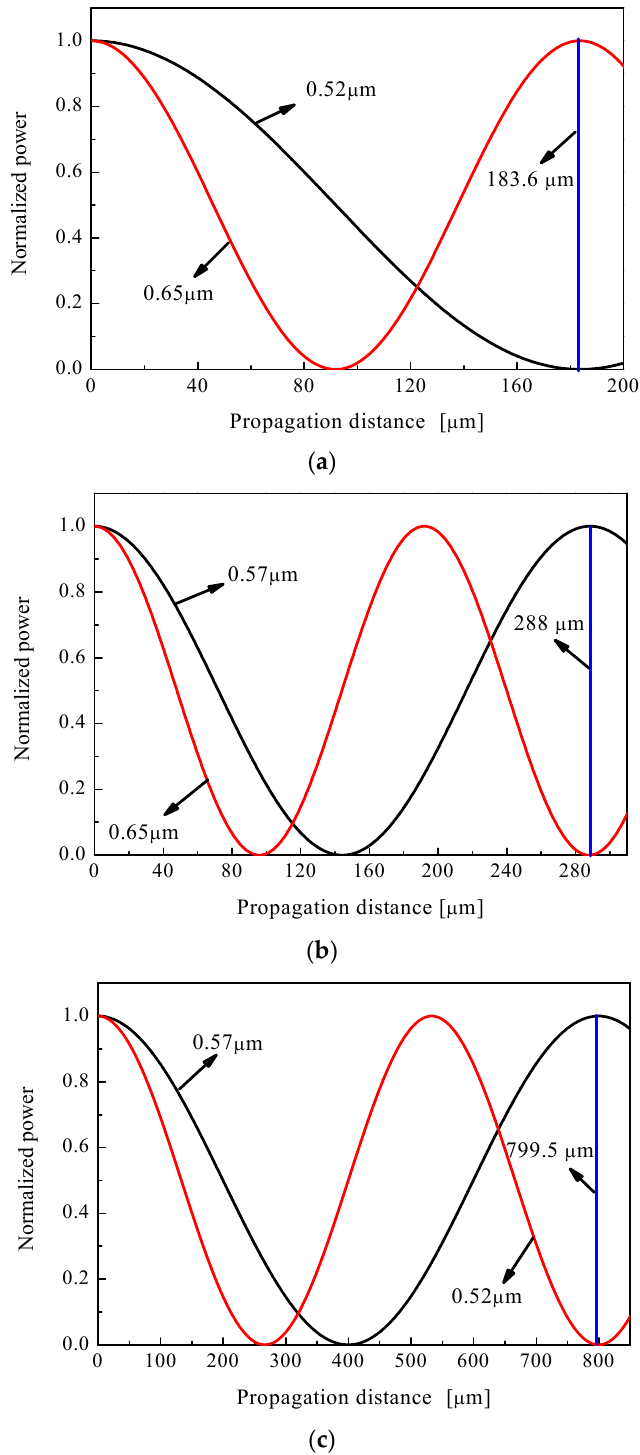
Figure 8. The propagation distance dependence of the normalized power for the three couplers, ( a ) at the wavelength of 0.52/0.65-μm, ( b ) at the wavelength of 0.57/0.65-μm, and ( c ) at the wavelength of 0.52/0.57-μm.